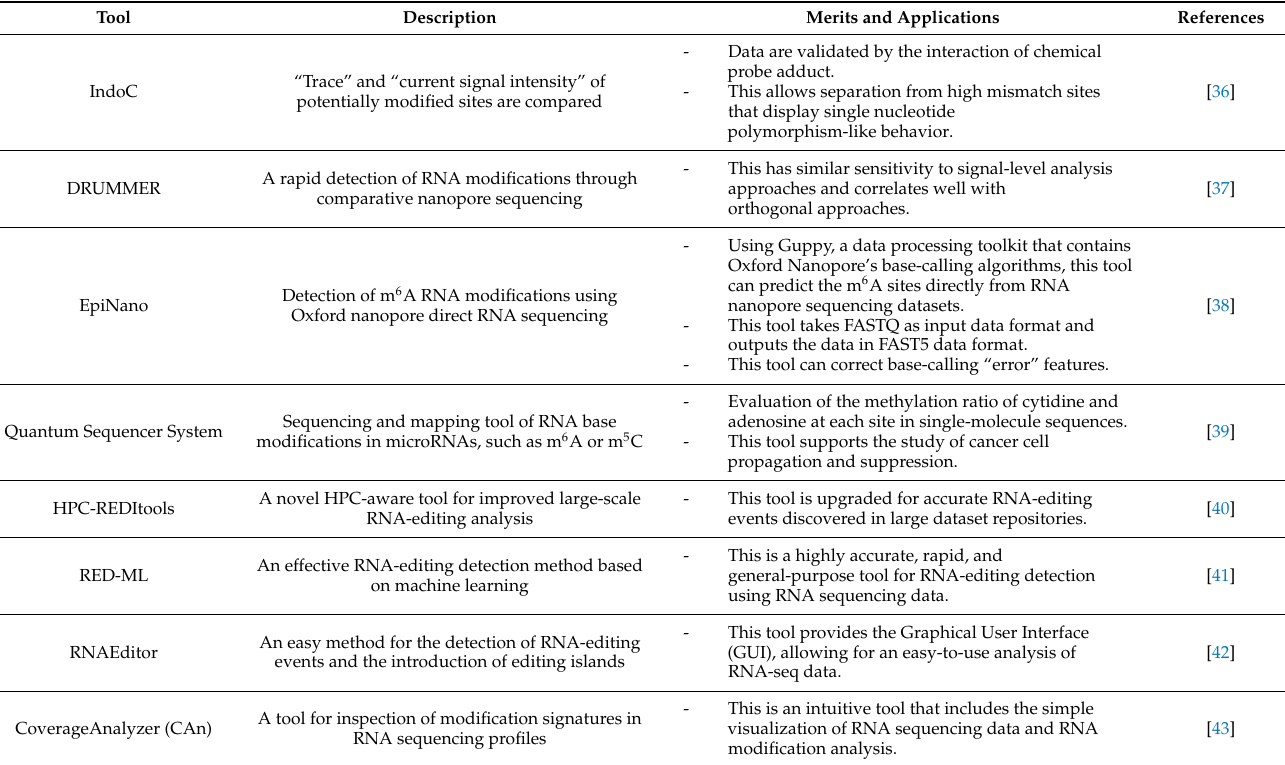
Table 1. Recently developed analysis tools for RNA modifications. Description Merits and